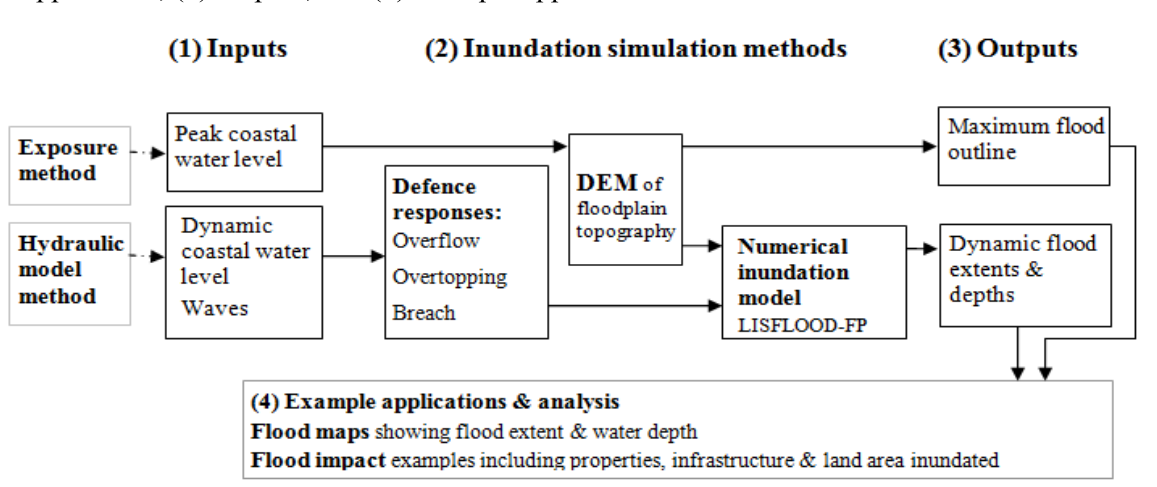
Figure 4. Method and model overview showing ( 1 ) inputs; ( 2 ) inundation simulation approaches; ( 3 ) outputs; and ( 4 ) example